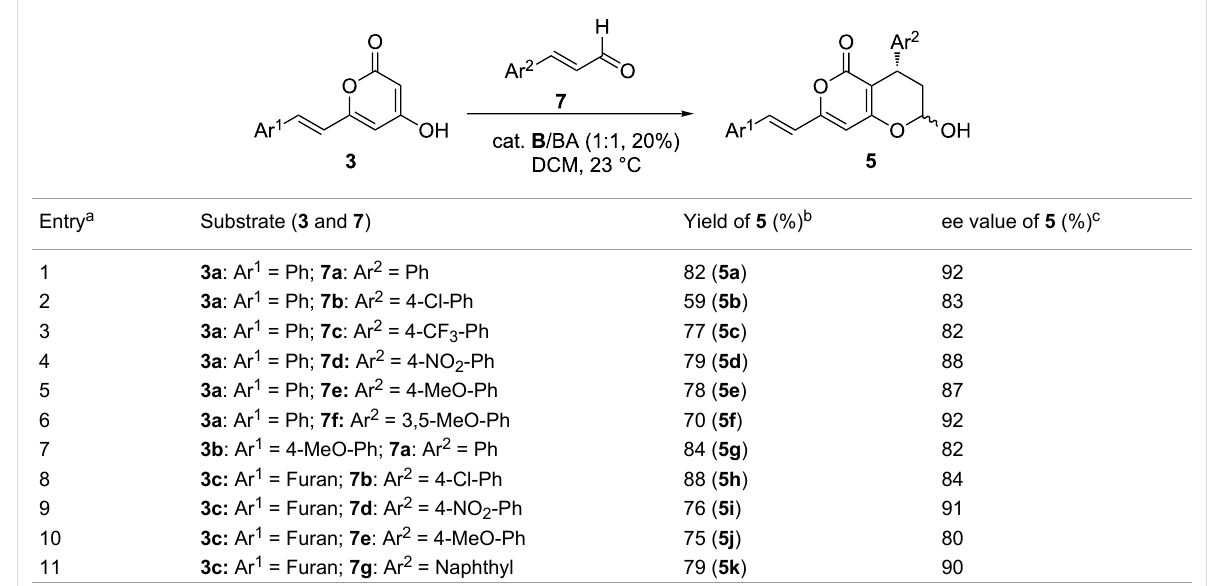
Table 2: Substrate scope of organocatalytic 1,4-conjugate addition/hemiketalization of styryl-2-pyranones with α , β -unsaturated aldehydes.